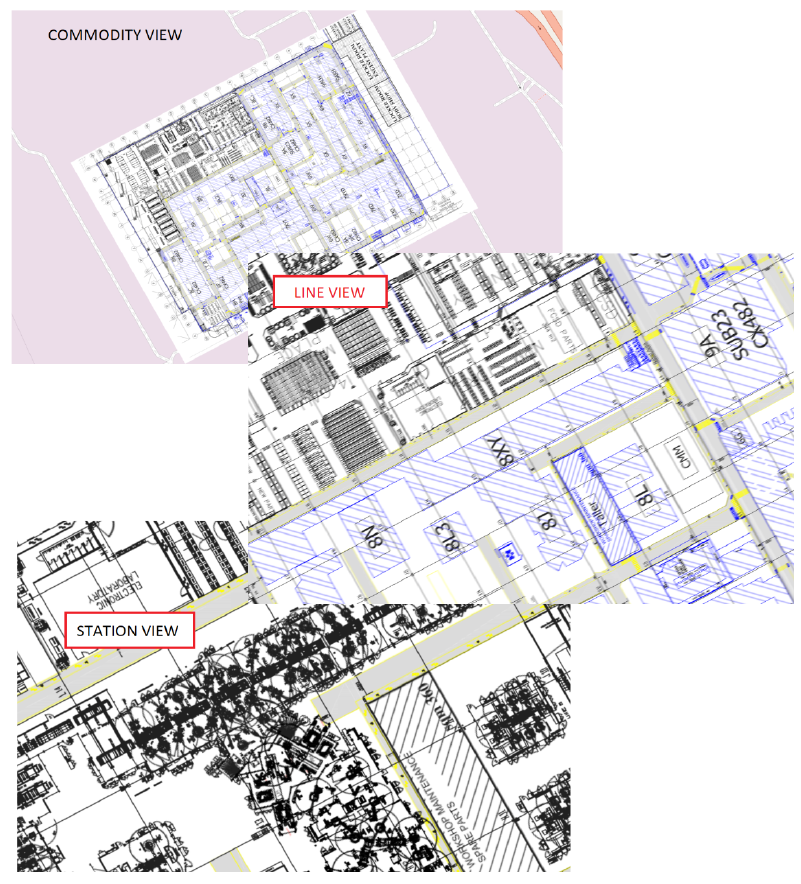
Figure 5. Manufacturing map